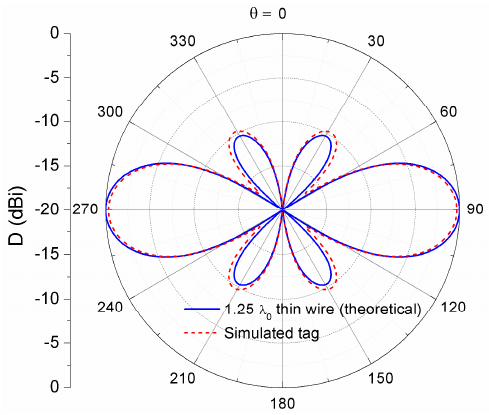
Figure 2 . Directive gain in the e -plane, normalized to a directivity value of D 0 = 5.2 dBi.